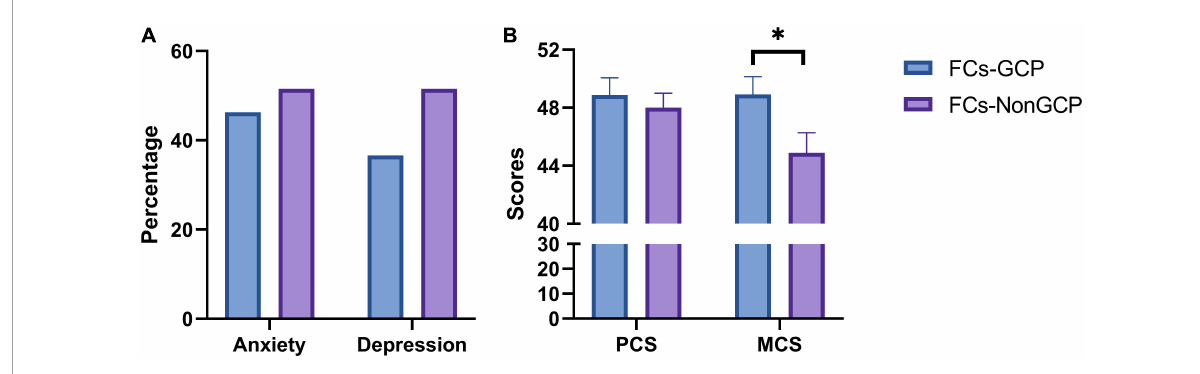
FIGURE1 (A) Prevelance of anxiety and depression in FCs-GCP and FCs-Non-GCP. (B) Scores of SF-12 in FCs-GCP and FCs-Non-GCP. ∗ P < 0.05.